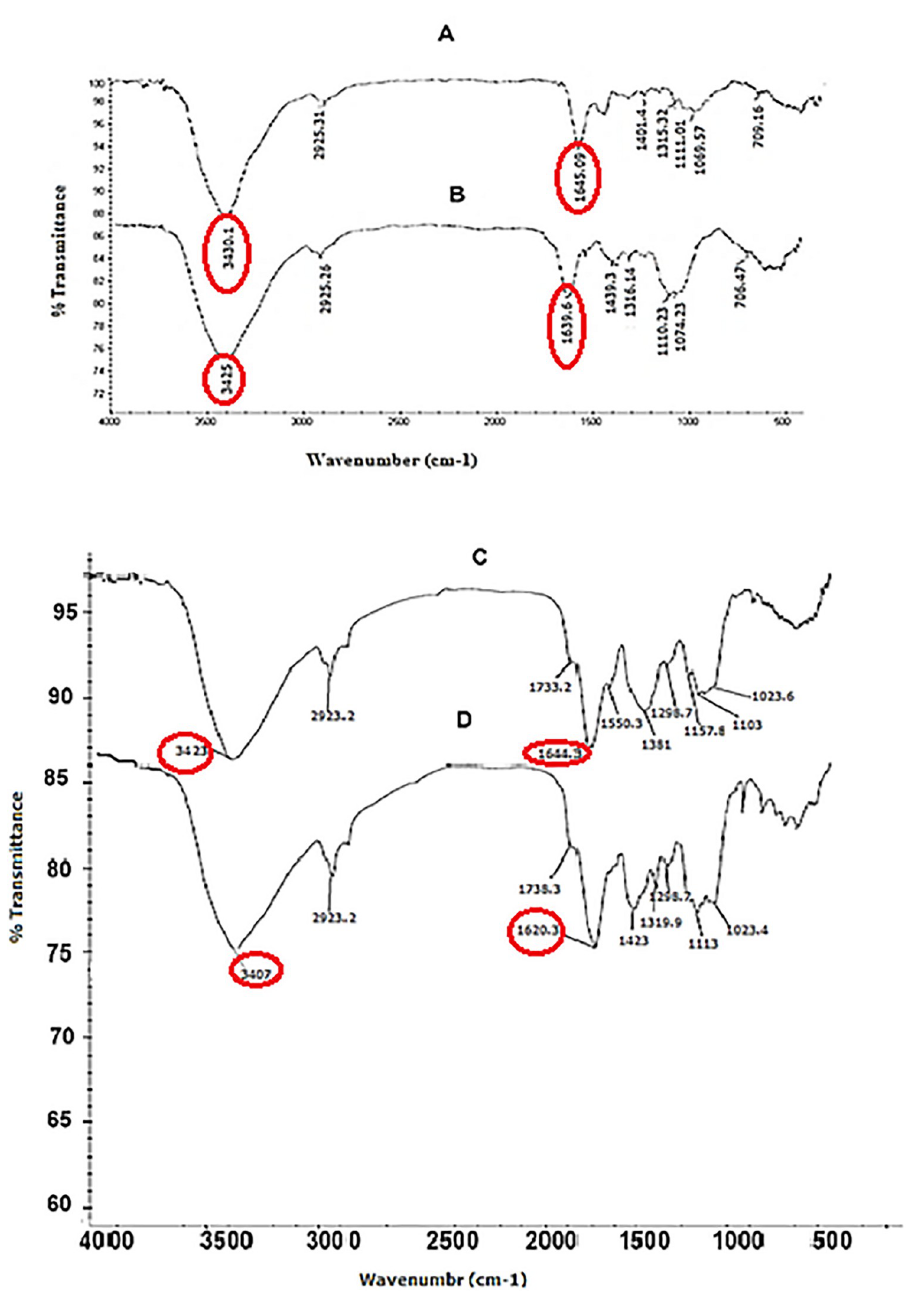
Fig 5. Structure analysis of purified recombinant protein (A) and CCL21 antigen (B), transgenic line (C) and non- transgenic line (D) by FTIR. Similar peak positions were observed in the spectra of A and B; differences can be observed in 3000–3500 cm -1 region (the peak at 3430 cm -1 in A and the peak at 3425 cm -1 in B), which are related to OH and NH 2 in B, CO carbonyl (1500–2000 cm -1 ) has an absorption spectrum of 1645 in purified A, while corresponding value is 1639 cm -1 in B. The spectra showed different peak positions in C and D; the peak was at 3423 cm -1 in C and 3407cm -1 in D. The absorption spectrum was 1644 in C and 1620 cm -1 in D.